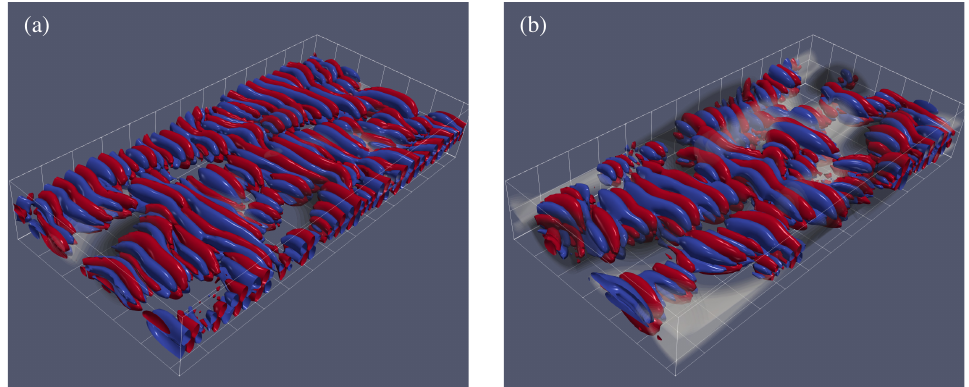
Figure 11. Spanwise-oriented structures and large-scale flows in the decomposed velocity fields for Re = 10 at ( a ) Wi = 20 and ( b ) Wi = 30. The red and blue isosurfaces represent spanwise- oriented structures indicated by Q at Q ∗ = 0.01 and − 0.01, respectively. Black and white transparent isosurfaces represent large-scale flows indicated by u l ∗ = 0.005 and − 0.005, respectively.